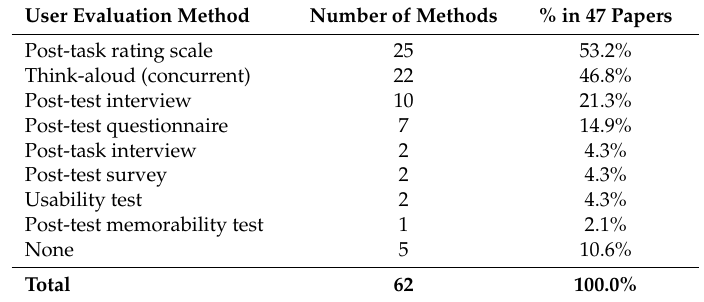
Table 8. User evaluation methods of proposed gestures in elicitation studies examined (possibly more than one method per